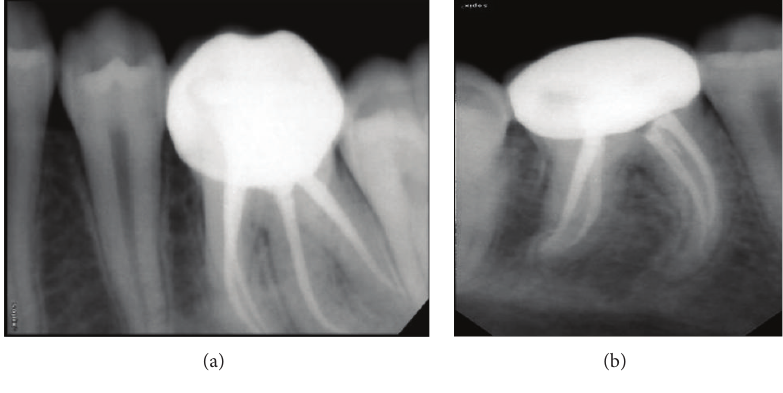
Figure 8: Postoperative IOPA of 36 and